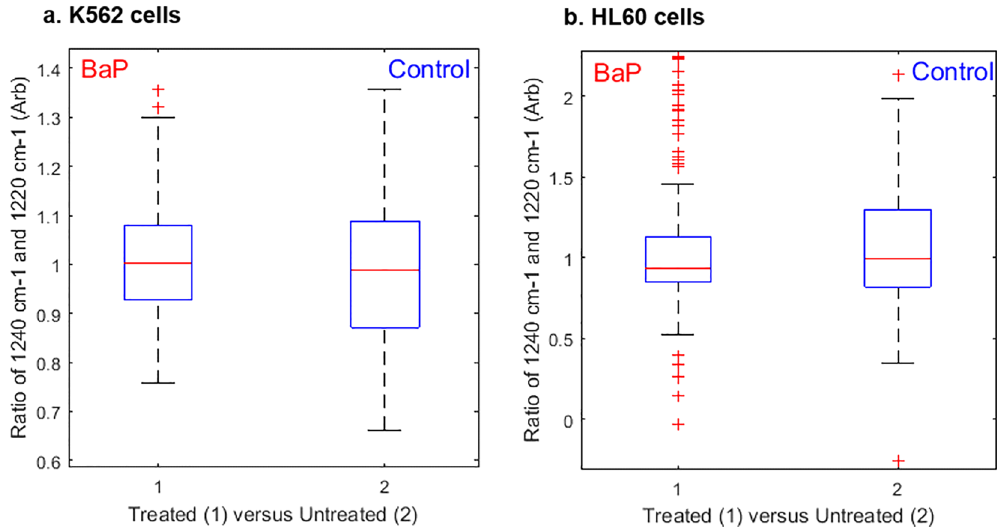
Figure 6. Box and whisker plots of peak height ratios for the asymmetric phosphate stretch at 1240:1220 cm − 1 calculated for the entire cell population of K562 cells ( a ) and HL60 cells ( b ) analysed by S-FTIR. The median line indicates no significant shift in asymmetric phosphate stretch peak position between control and drug treated cells for either cell